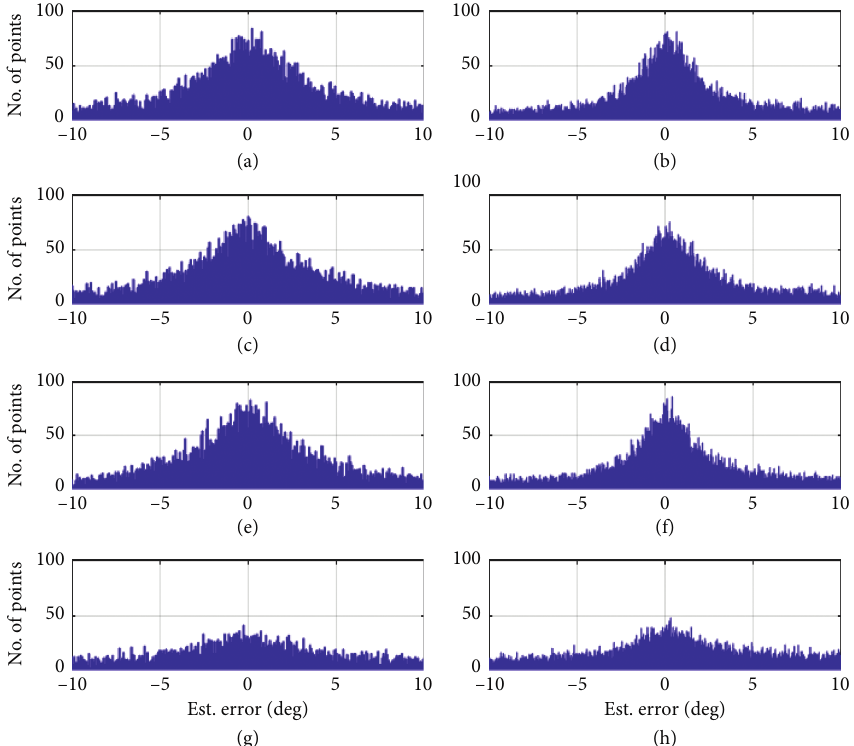
Figure 13: The histograms of Az (left column) and El (right column) estimation errors, when − 20dB ≤ SNR ≤ − 10dB with 1025 snapshots. (a, b) WF-1; (c, d) WF-2; (e, f) WF-3; (g, h)